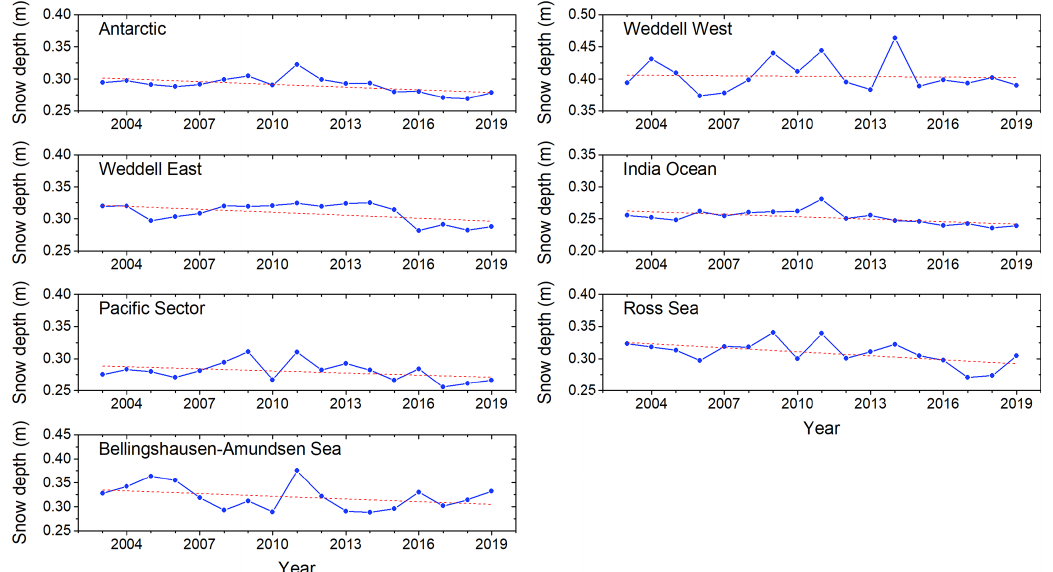
Figure 10. Time series of the annual snow depth estimates derived from the proposed method from 2003 to 2019 for the Antarctic and six sea sectors at the spatial resolution of